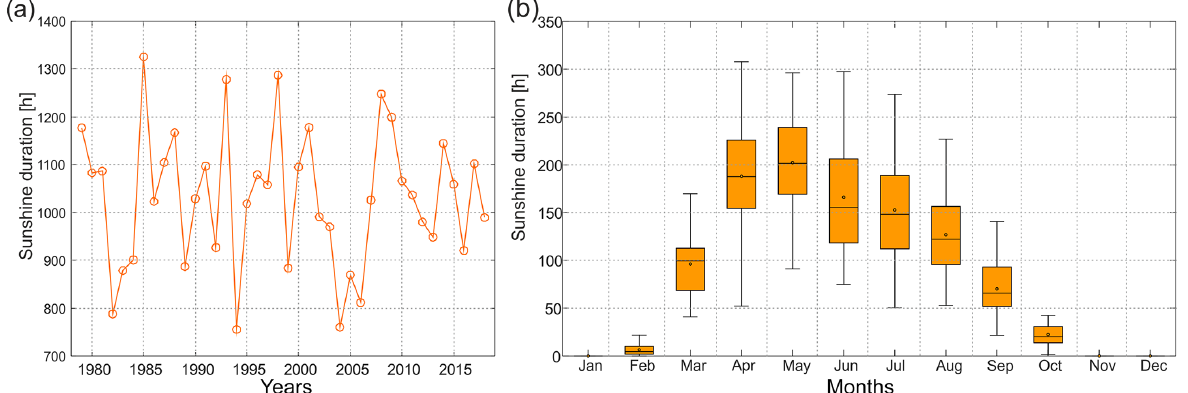
Figure 8. (a) Variability of mean annual sunshine duration in 1979–2018 at Hornsund. (b) Variability of the monthly sums of sunshine duration at Hornsund in the period